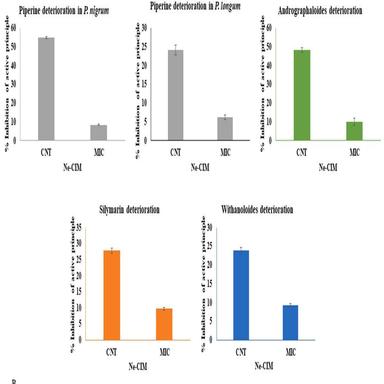
A. In-situ preservative efficacy of Ne-CIM: percentage inhibition of fungal growth and AFB1 contamination on]selected herbal raw materials during their 12 months of storage.